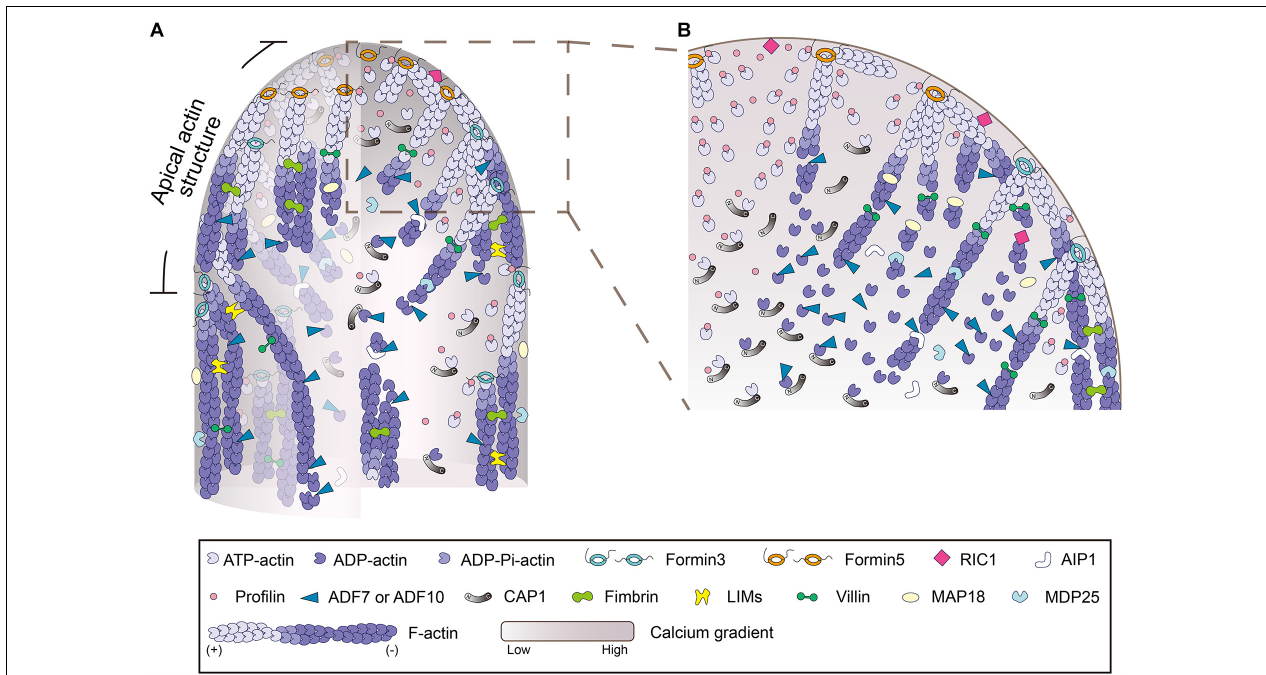
FIGURE 2 | Schematic depiction of the regulation of actin polymerization and dynamics in the pollen tube. (A) Schematic depiction of the intracellular localization pattern and function of various ABPs in pollen tube growth domain. The model is mainly based on data from Arabidopsis . (B) An enlarged picture of the boxed region in (A) is presented in order to show more details about the regulation of actin polymerization and dynamics in the tip of pollen tube. In brief, within the pollen tube, actin predominantly exists in the monomeric form. It is buffered by an equimolar amount of profilin to form actin-profilin complexes. Actin polymerization is initiated by membrane-anchored formins, which utilize actin-profilin complexes within the cytoplasm. The membrane-originated actin filaments assume distinct distributions in space as described in Figure 1G , and they are turned over by ADF and its cofactors, including AIP1 and CAP1, and several Ca 2 + -responsive actin severing proteins, which promote the dynamics and control the length of actin filaments. Under the action of various actin bundling/crosslinking proteins, including villins (Qu et al., 2013), LIMs (Wang et al., 2008; Papuga et al., 2010; Zhang et al., 2019), and fimbrins (Su et al., 2012; Zhang et al., 2016), membrane-originated actin filaments are organized into distinct structures and assume distinct distributions in the cortical and inner regions of the pollen tube.